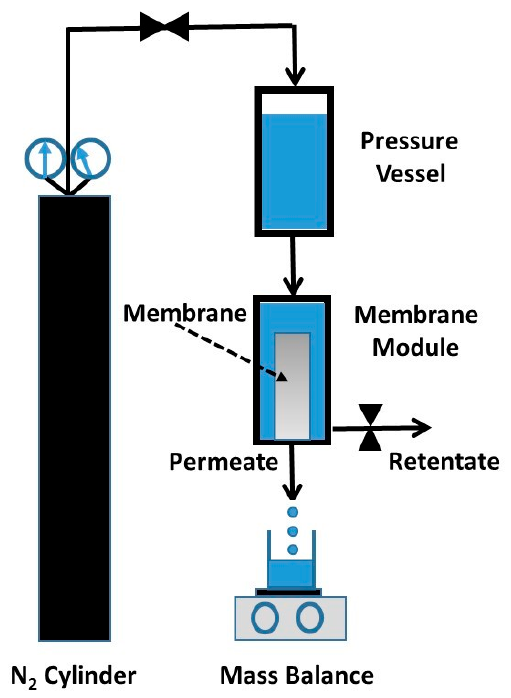
Figure 10. Schematic of the membrane experimental set up.